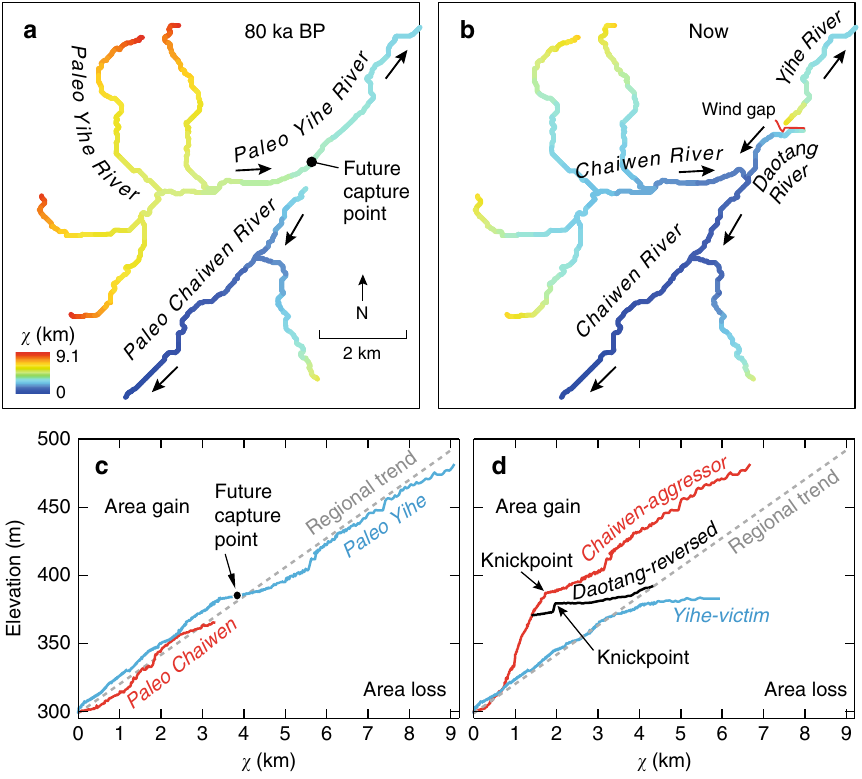
Fig. 4 River network and longitudinal pro fi le before and after river capture. a χ map for the river network before river capture. b χ map for the present river network. c χ -elevation plot for the Paleo Chaiwen and Yihe Rivers before capture. d χ -elevation plot for the present Chaiwen, Yihe, and Reversed Rivers. The data are from ref.